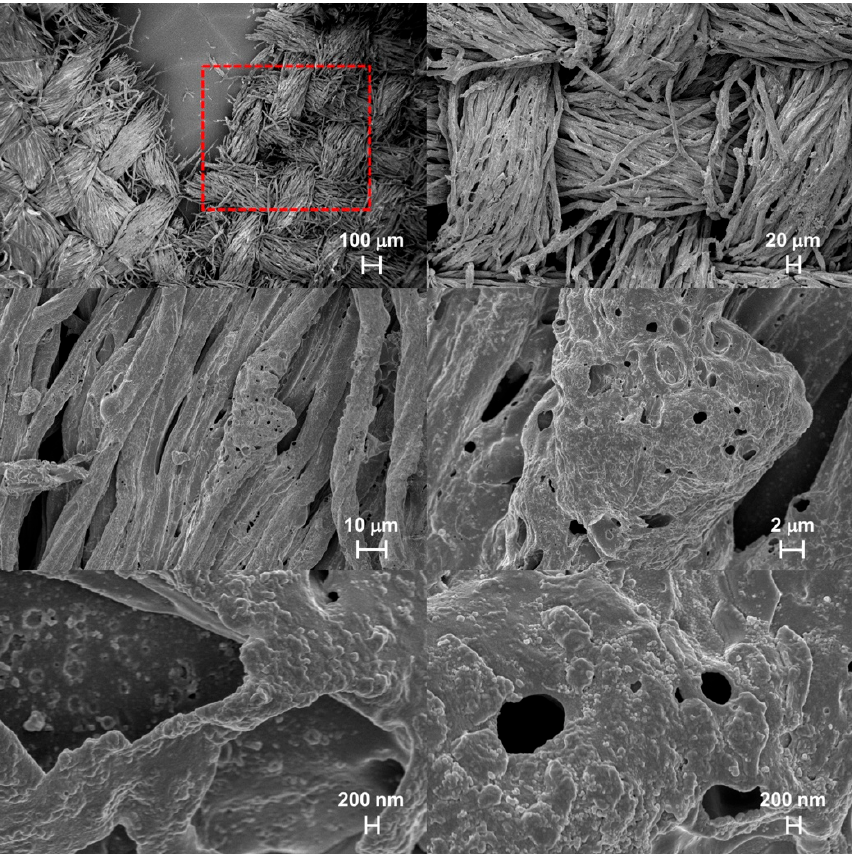
Figure 10. FE-SEM micrographs of COT/M–G 50 –C 50 residue after vertical flame spread tests.